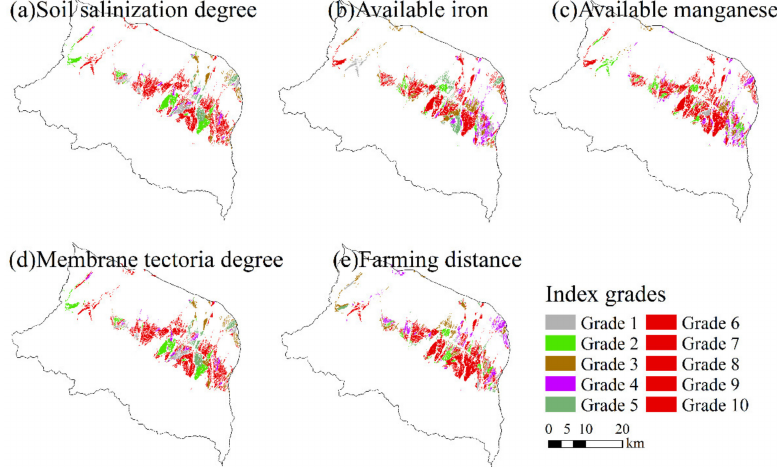
Figure 6. Spatial distribution of the influential factors at the piedmont slope. ( a ) Soil salinization degree, ( b ) Available iron, ( c ) Available manganese, ( d ) Membrane tectoria degree, and ( e ) Farm- ing distance.